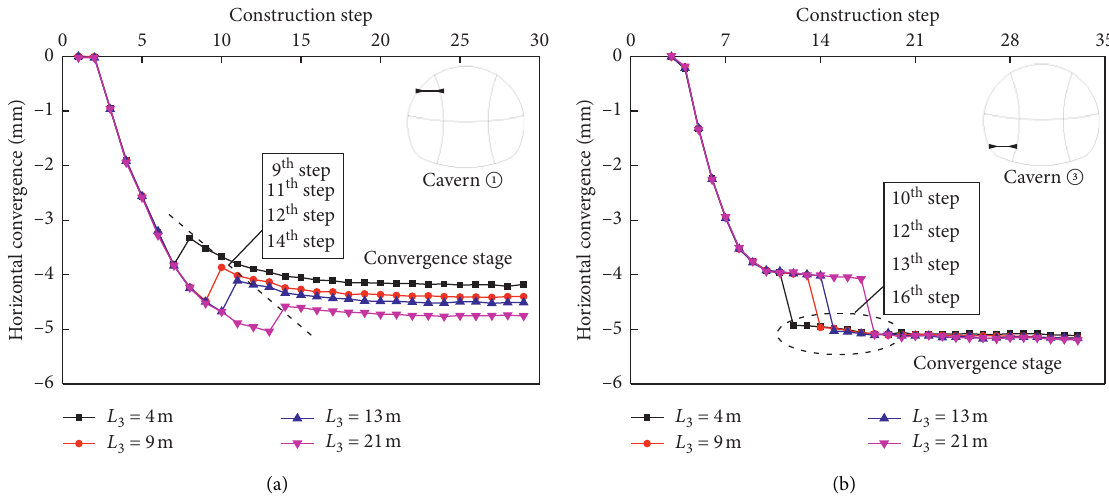
Figure 13: Horizontal deformation characteristics of caverns ① and ③ . (a) Horizontal convergence curve of cavern ① . (b) Horizontal convergence curve of cavern ③